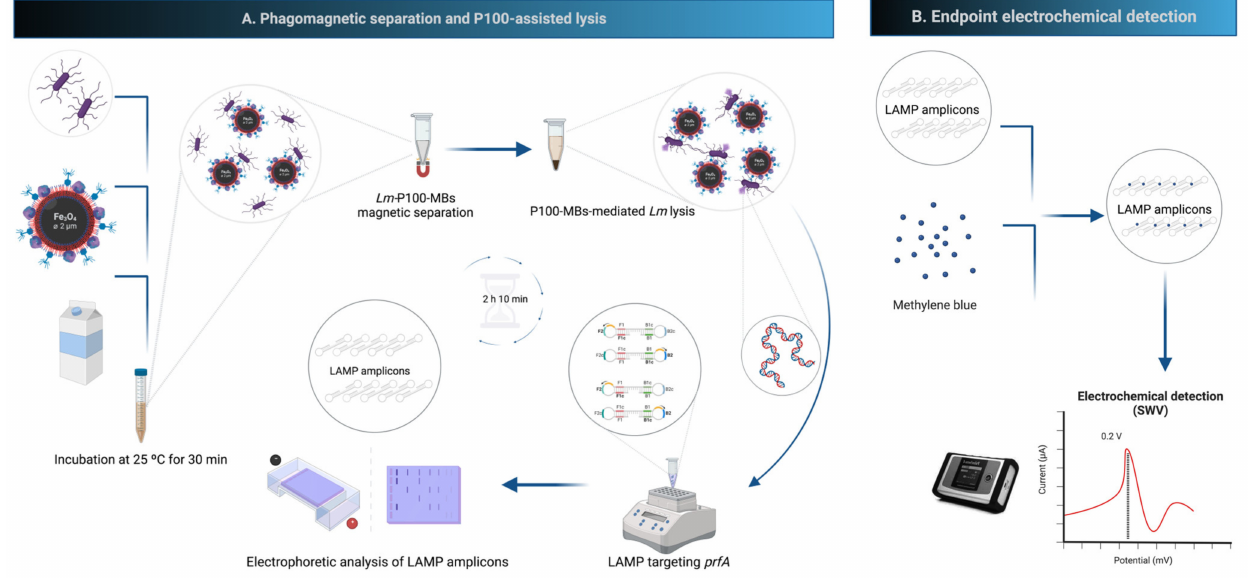
Figure 2. Schematic illustration of the validation of the integrated detection